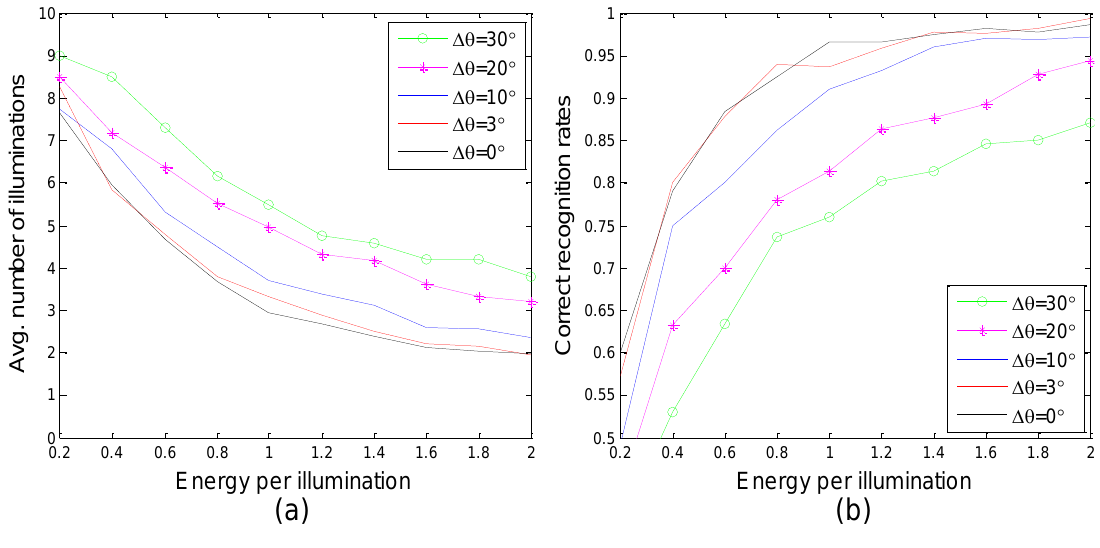
Figure 9. (a) Average number of illuminations to reach a decision and (b) correct recognition rates at the time when a decision has been made vs. energy per illumination for different estimation variances of the target aspect